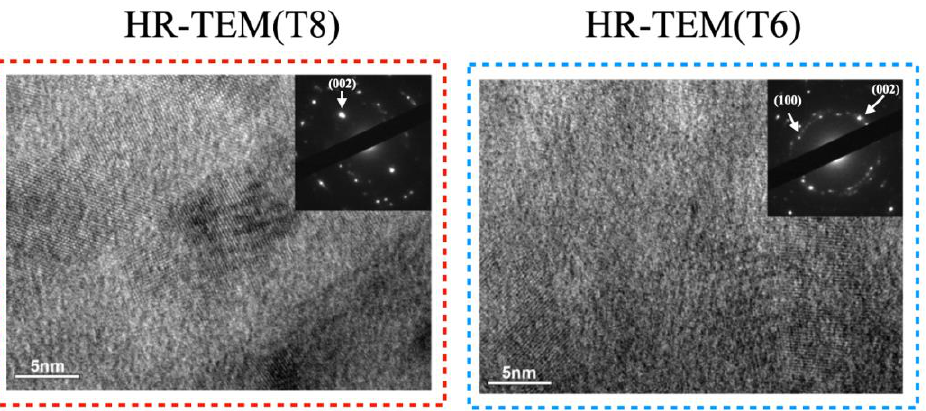
Figure 8. Bright field HR-TEM images with corresponding electron diffraction (SAED) pattern of a tensile group T8 and a compressive group T6.